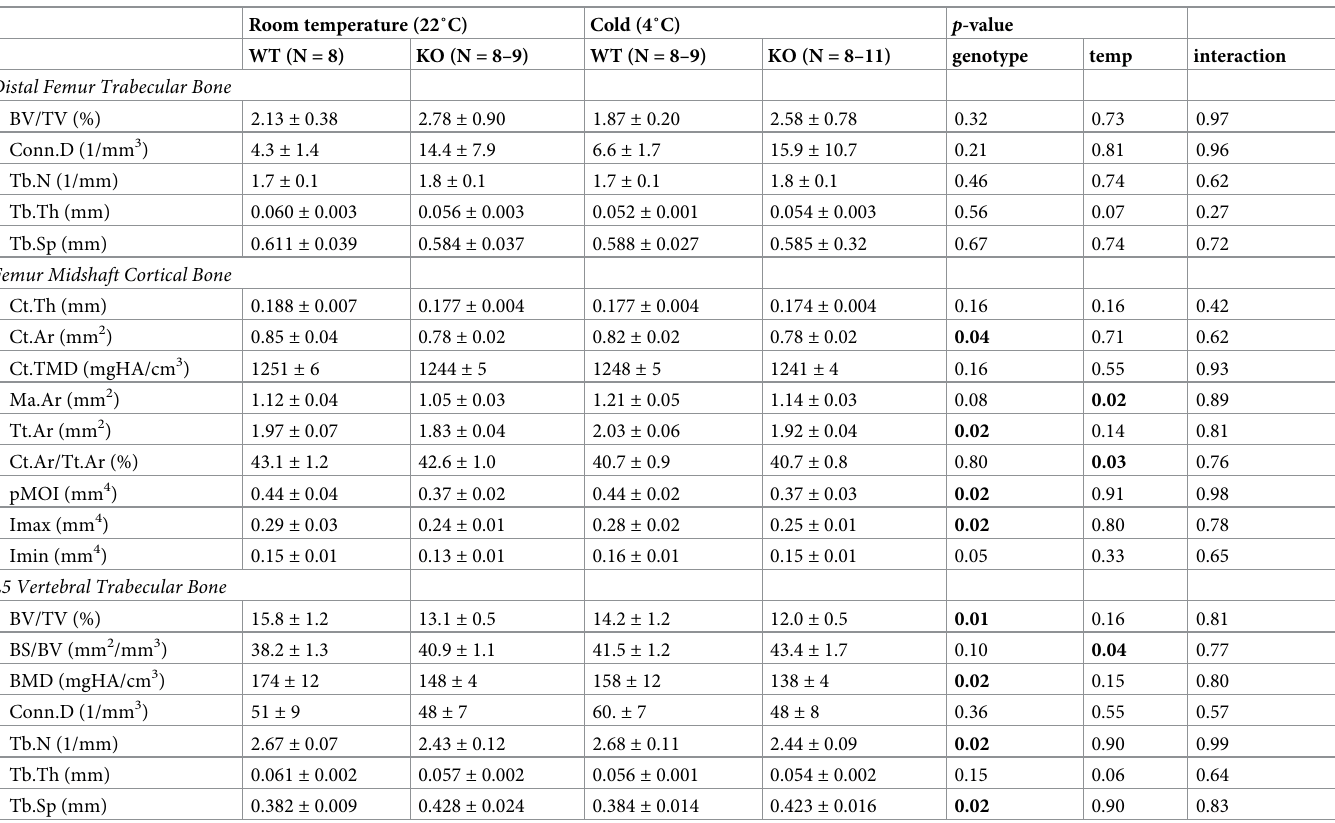
Table 2. Femoral and vertebral bone outcomes assessed by μ CT of female wildtype (WT) and Trpm8 - Knockout ( KO ) mice housed at room temperature or